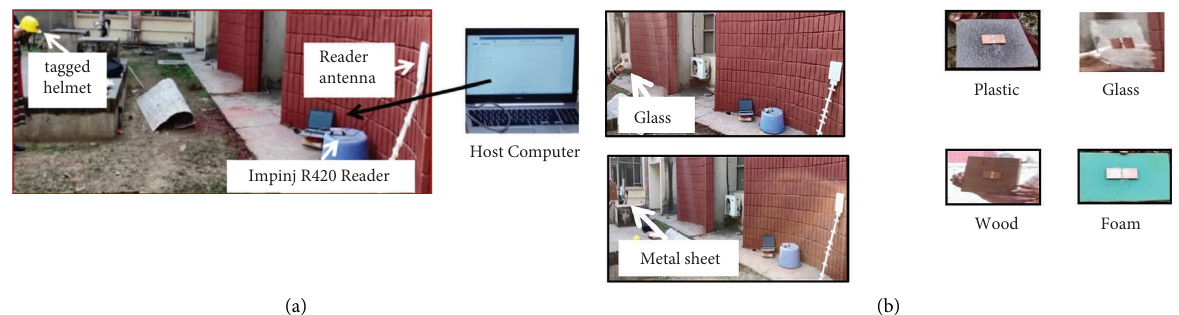
Figure 16: (a) Measurement set up (Impinj R 420 reader) to measure the read range performance of the designed tag in outdoor scenario. (b) Diferent material objects (metal-sheet, plastic, wood, and glass) on which tag is mounted.